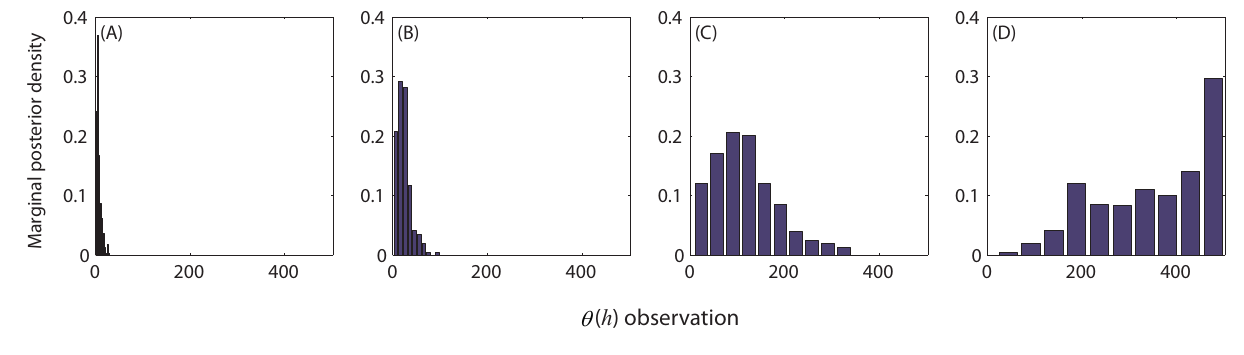
Fig. 6. Histograms of the posterior samples generated with DREAM ( D ) . The most informative soil water pressure head measurements are somewhat clustered at different moisture values that range from saturation (left plot) to the dry end (right plot). The x -axis indexes the observations [ 1 ,..., 501 ]